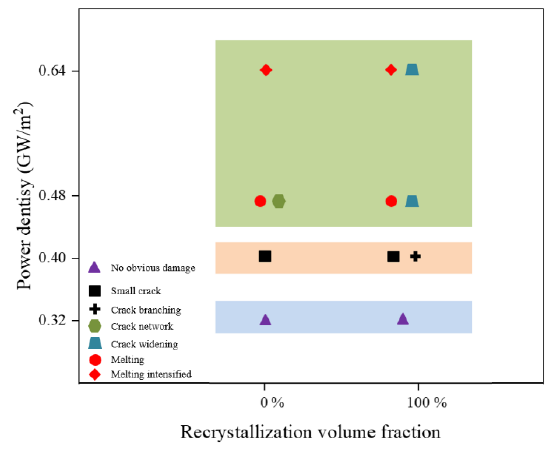
Figure 12. The distribution of surface damage characteristics of the rolled and fully recrystallized samples under laser thermal shock with different power densities.